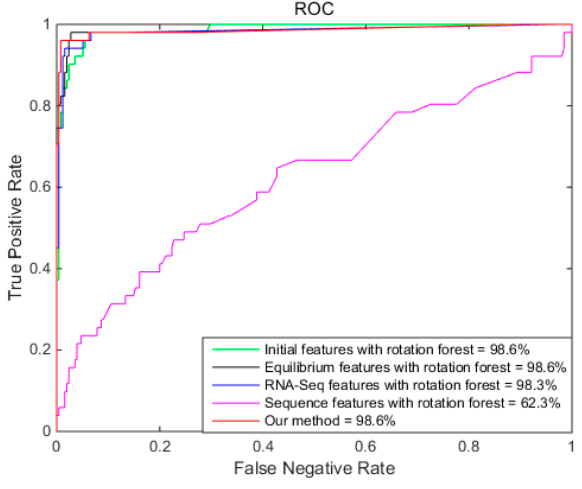
Figure 4. The ROCs of different features with Rotation Forest.